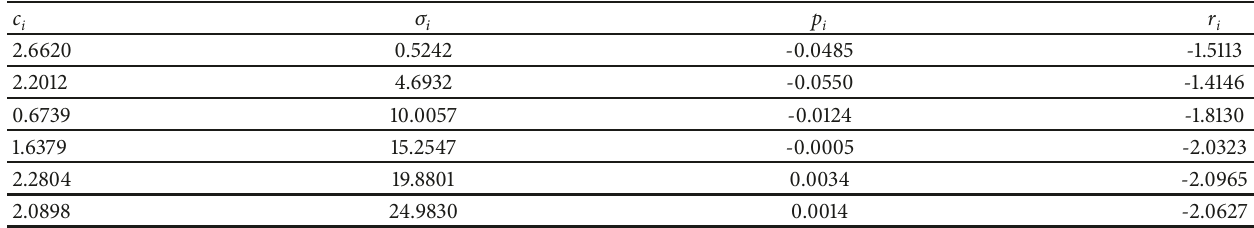
Table 3: Parameters of the ANFIS after training for the 2 nd joint (Case